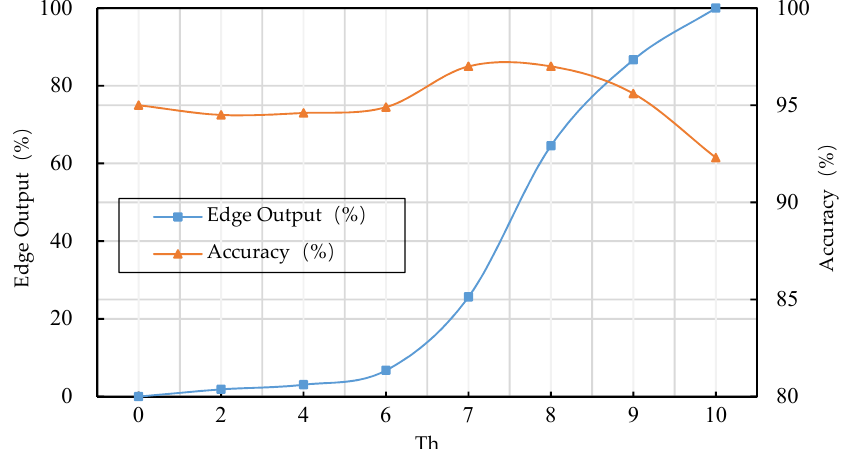
Figure 11. Impact of Th.